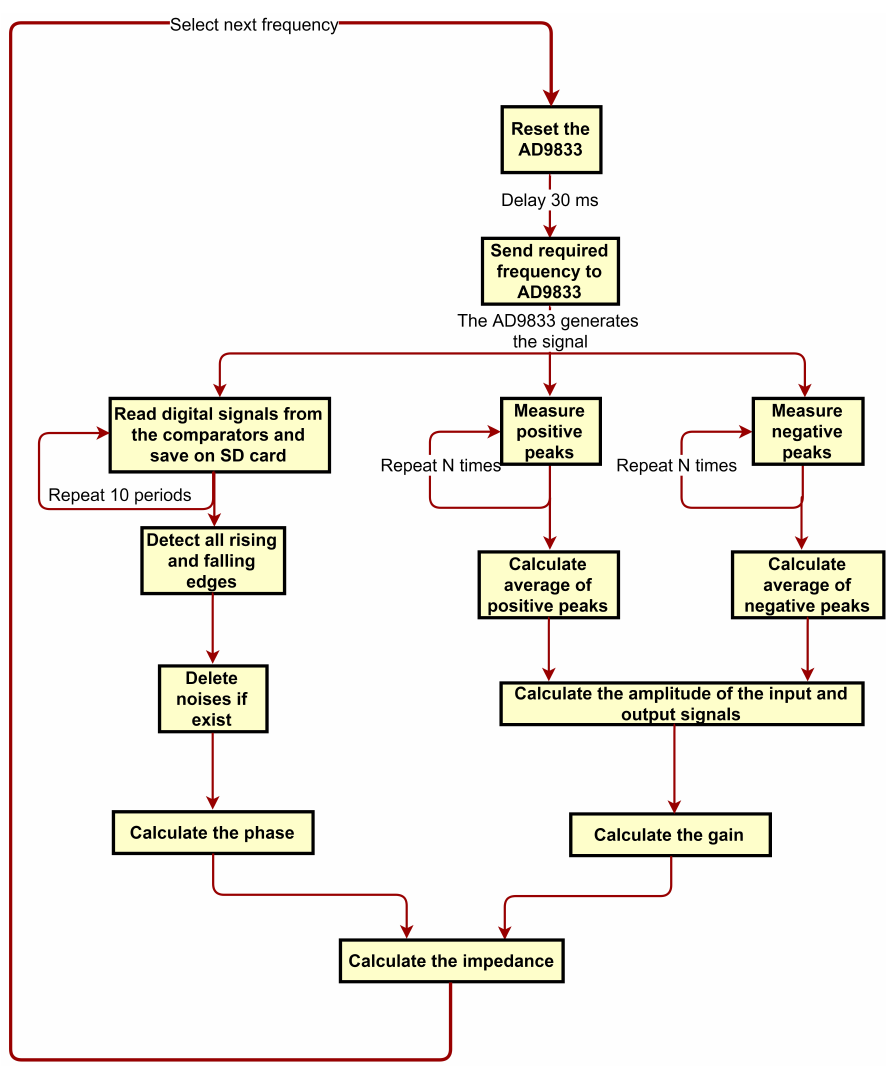
Figure 14. Chart flow of impedance